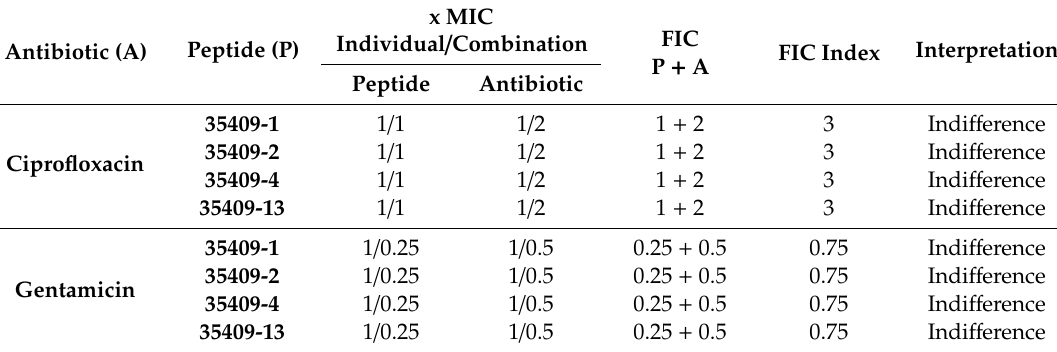
Figure 1. Circular Dichroism (CD) spectra for original peptide 35409 and its short derivatives. Possible secondary structure elements were studied in 1X PBS and 1X PBS with 10 mM SDS regarding peptides which were active or inactive against E. coli . Table 2. Synergy with conventional